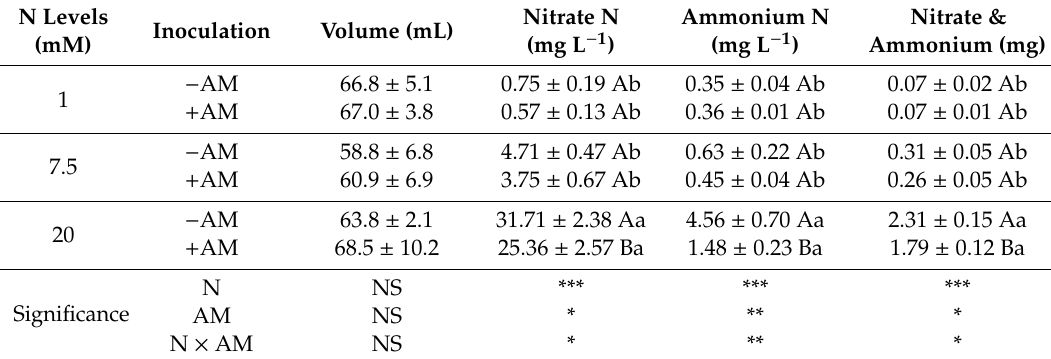
Table 1. The N leaching in poplar